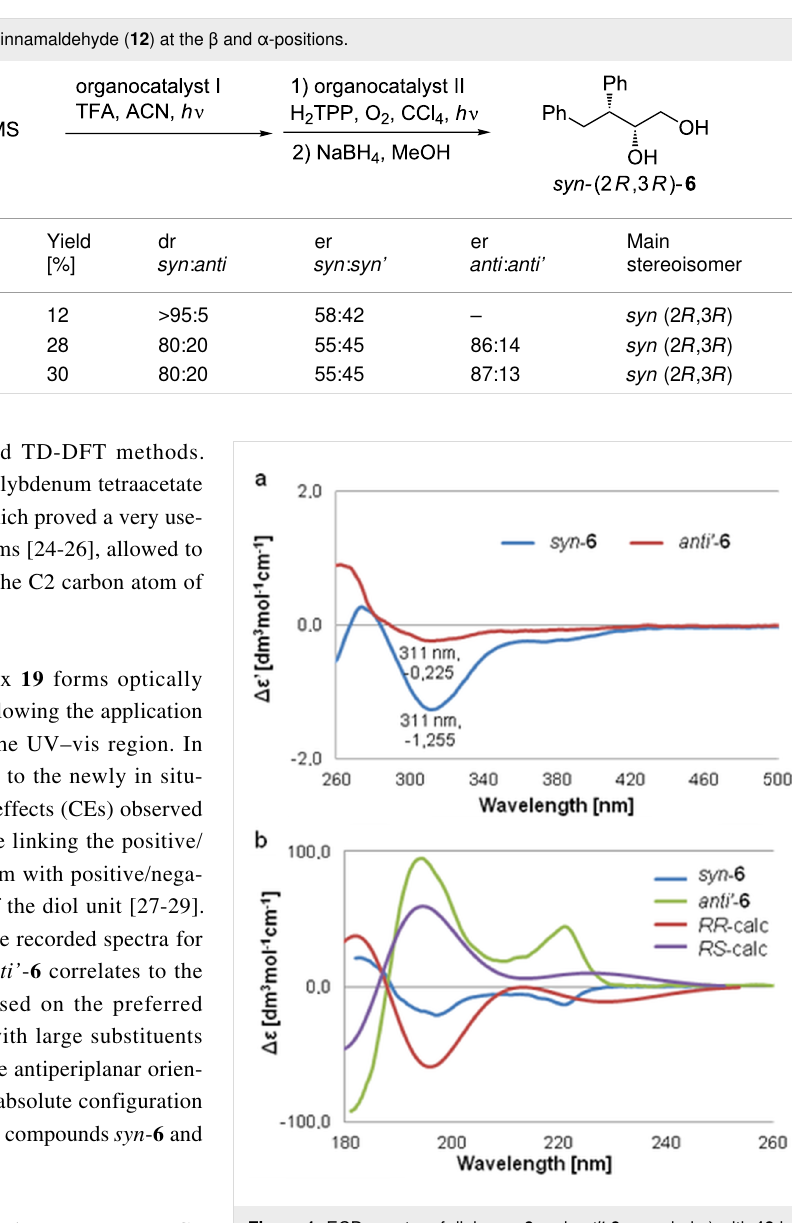
Figure 1: ECD spectra of diols syn - 6 and anti’ - 6 recorded a) with 19 in DMSO and b) in acetonitrile compared with simulated ECD